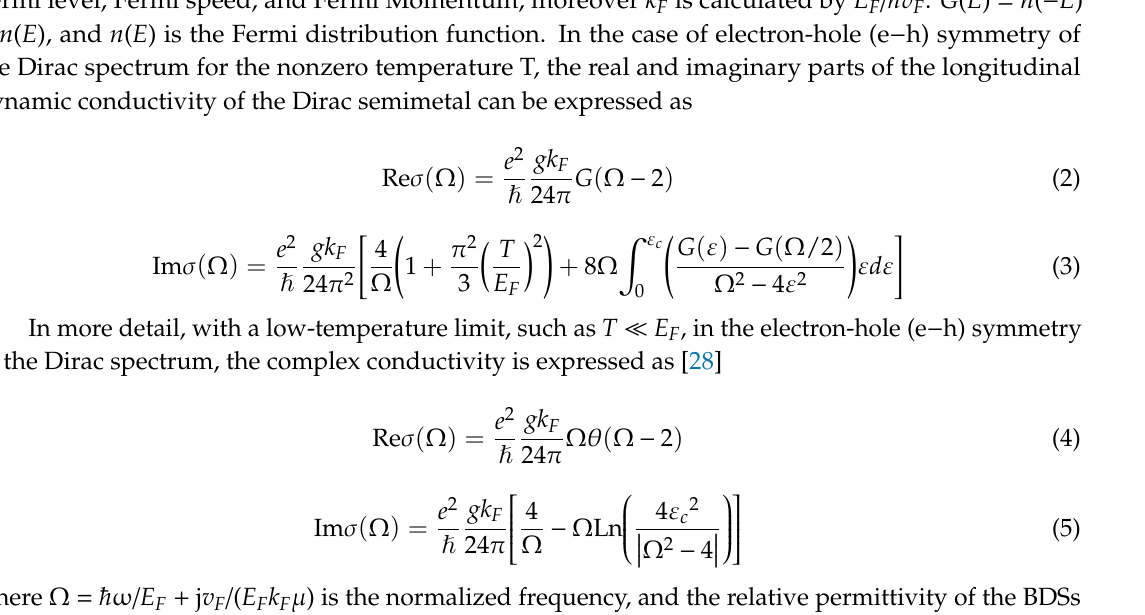
Table 1. Representative Bulk Dirac semimetals (BDSs) with different ε b and g.